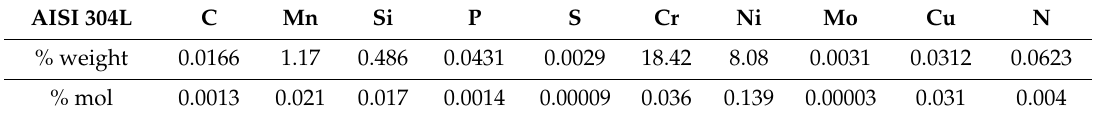
Table 1. Chemical composition (% by weight and % by mol) of AISI 304L stainless steel.